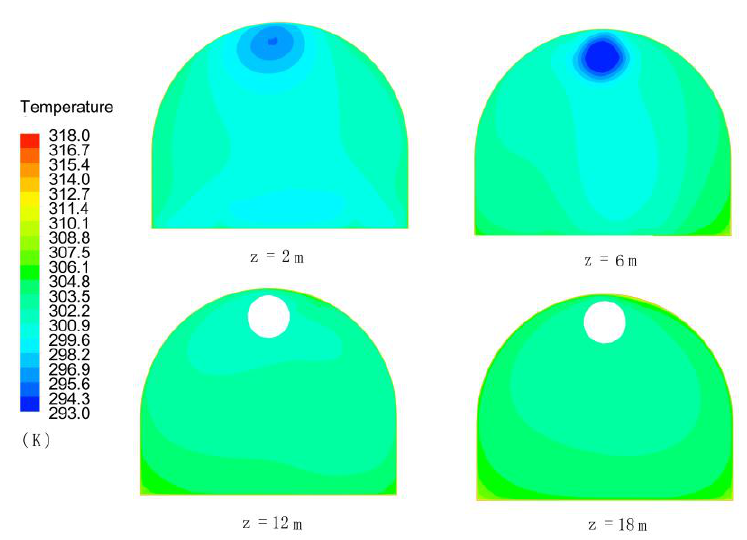
Figure 6. Model 2 section temperature distribution.